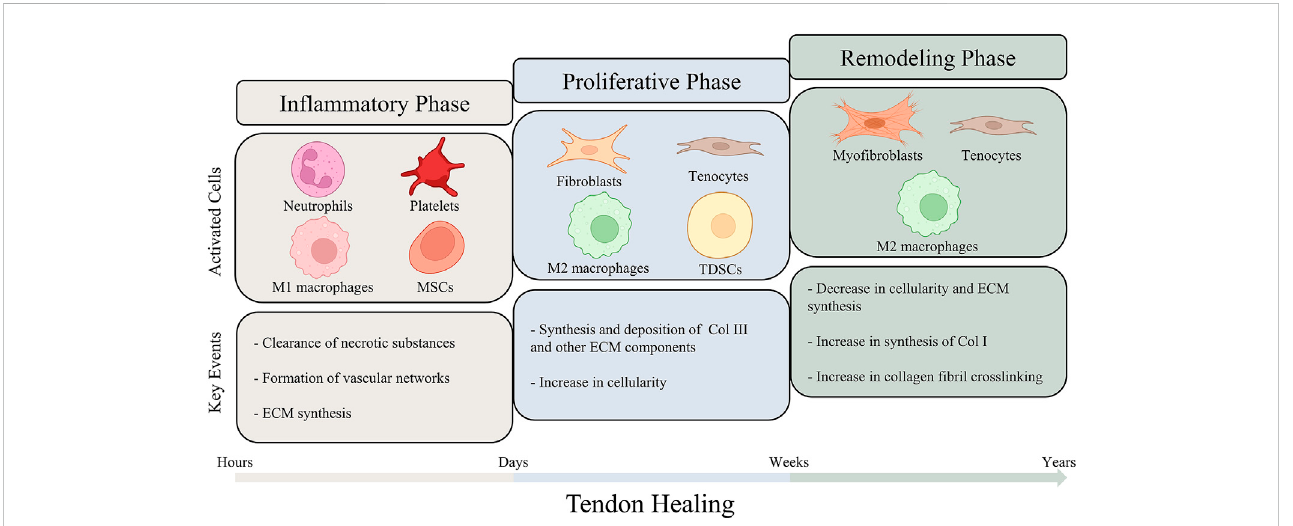
FIGURE 2 A schematic illustration of the different phases of tendon healing. The process of tendon healing could be divided into three overlapping phases: in fl ammatoryphase,proliferativephaseandremodelingphase.Astendonhealingprogresses,differenttypesofcellsareactivatedandleadtosequenceofkey events. The fi gure also summarizes the estimated durations of the three